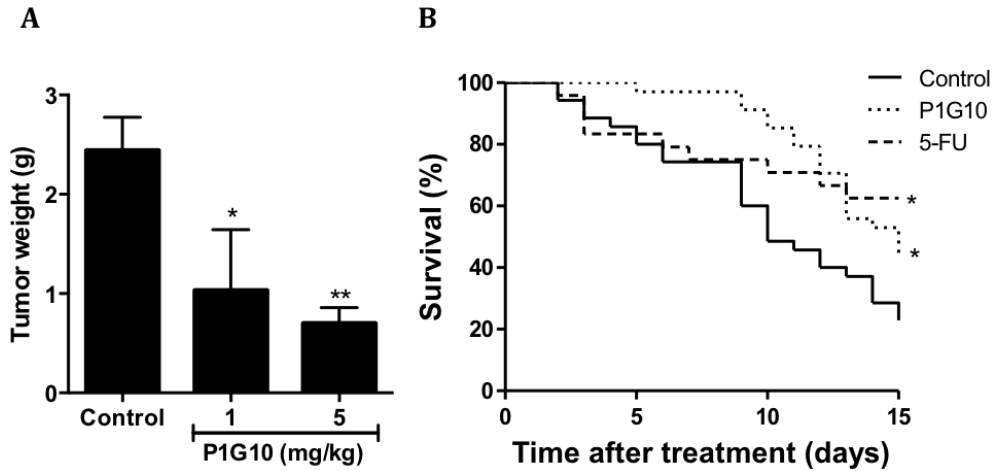
Figure 1. P1G10 antitumoral activity and survival in murine melanoma B16F1. ( A ) C57Bl6 mice ( n = 40) were subcutaneously ( s.c. ) inoculated with B16F1 (5 × 10 5 cells/100